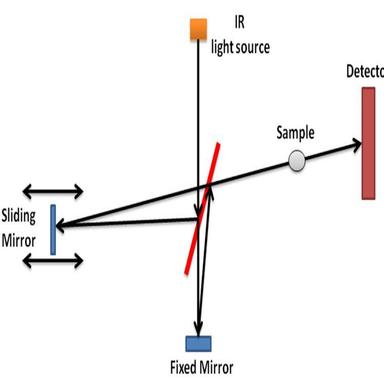
The FT-IR spectra phenomena which used for samples analysis.